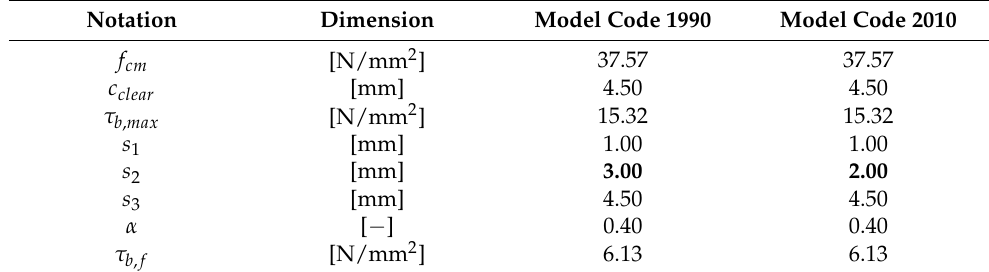
Table 2. Comparison of the 2010 and 1990 versions of Model